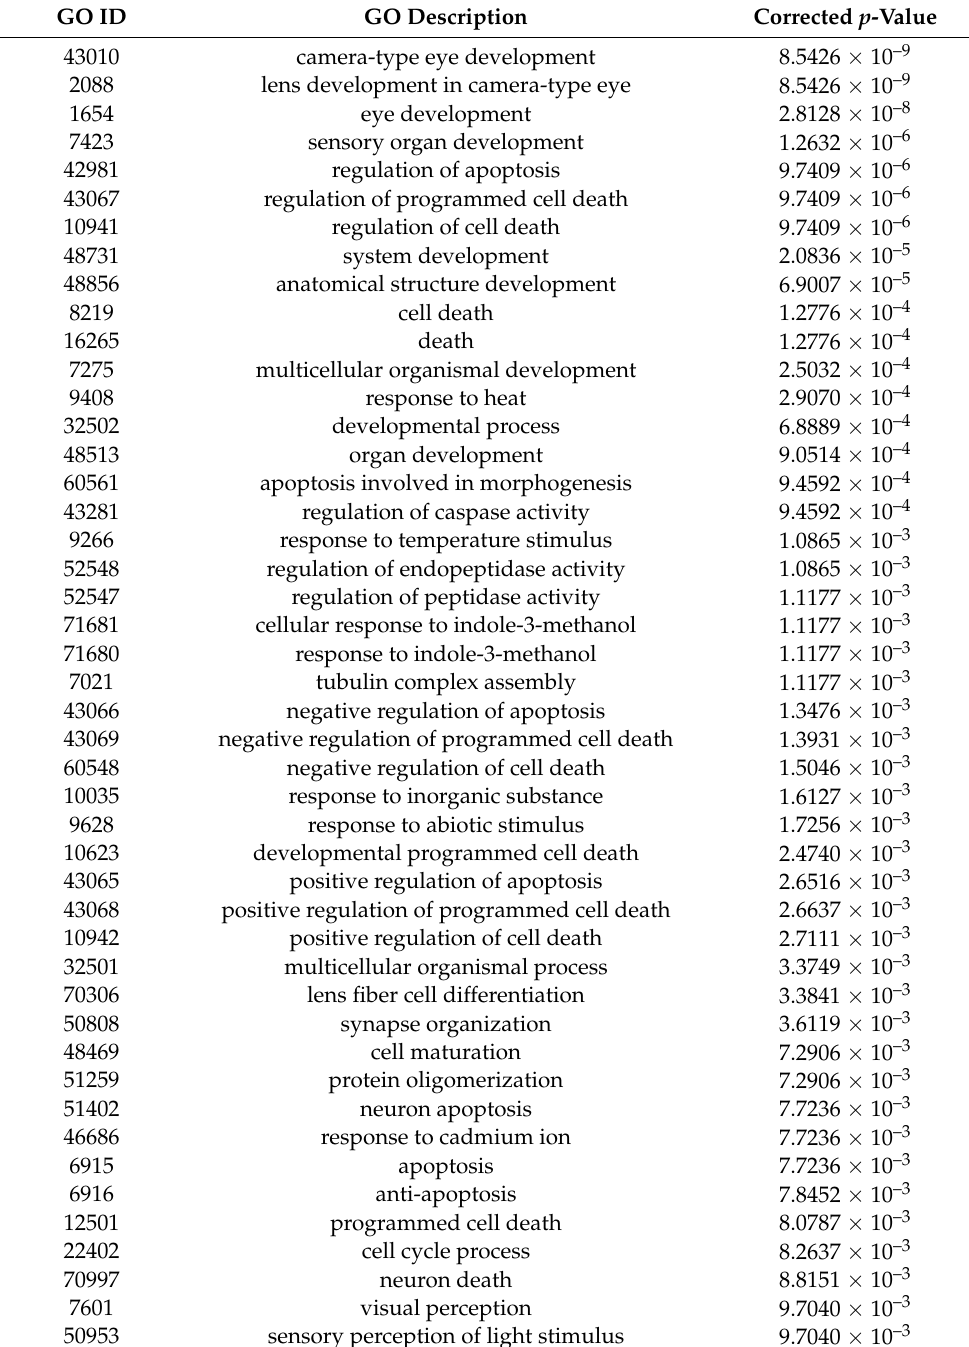
Table 2. Enriched biological functions related to HSPB5